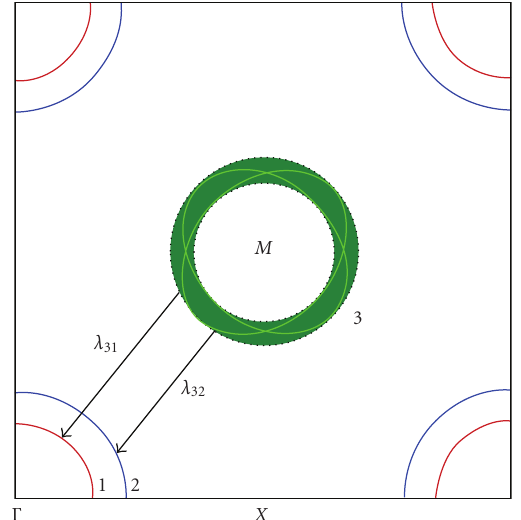
Figure 1: Schematic drawing of the multiband model used in this work. The two hole bands (1 and 2) are centered around the Γ point, while the equivalent electron band (3) around the M point of the reduced Brillouin